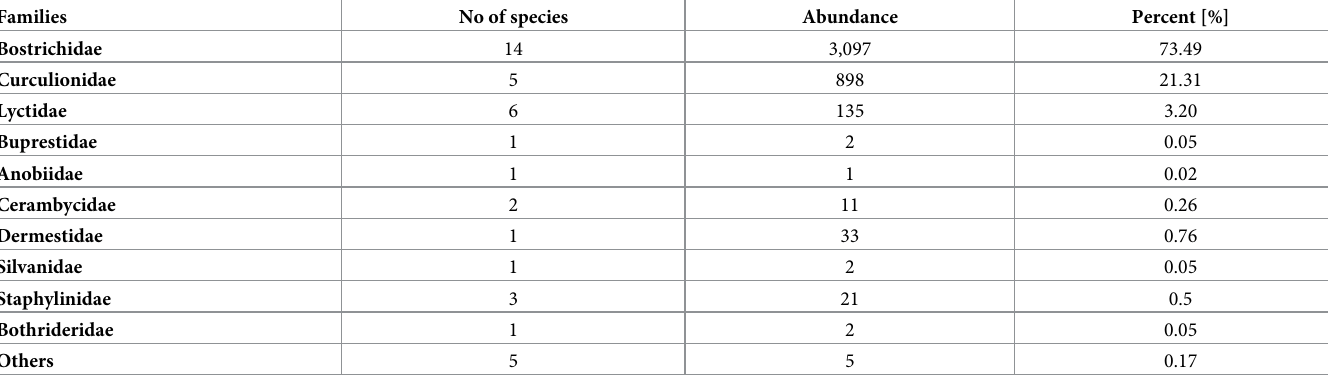
ray, Xylopsocus sp., and Dinoderus gabonicus Lesne. The most abundant species in KU were X . adustus followed by S . doliolum with 1,915 and 137 beetles accounting for 88.4% and 6.23%, respectively [Table 4]. In Mitaboni, the abundant species were S . ruficorne , S . doliolum , X . picea and X. nitidipennis accounting for 33.9%, 19.9%, 15.5 and 10.3%, respectively. Sinoxylon ruficorne was only recorded in Mitaboni while D . gabonicus in KU [S2 File]. Other than the wood-boring beetles, both predators and parasitoids were recovered at Ken- yatta University and Mitaboni. The predators included the families Histeridae, Cleridae, Ela- teridae, Laemopholoidae, Latridiidae, Ciidae, Anthocoridae and Pseudoscorpionida while the parasitoids included Ichneumonidae, Braconidae, Eulophidae, Chalcididae and Pteromalidae which were recorded in both regions. However, Eurytomidae and Eupelmidae were recorded in KU and Mitaboni, respectively.